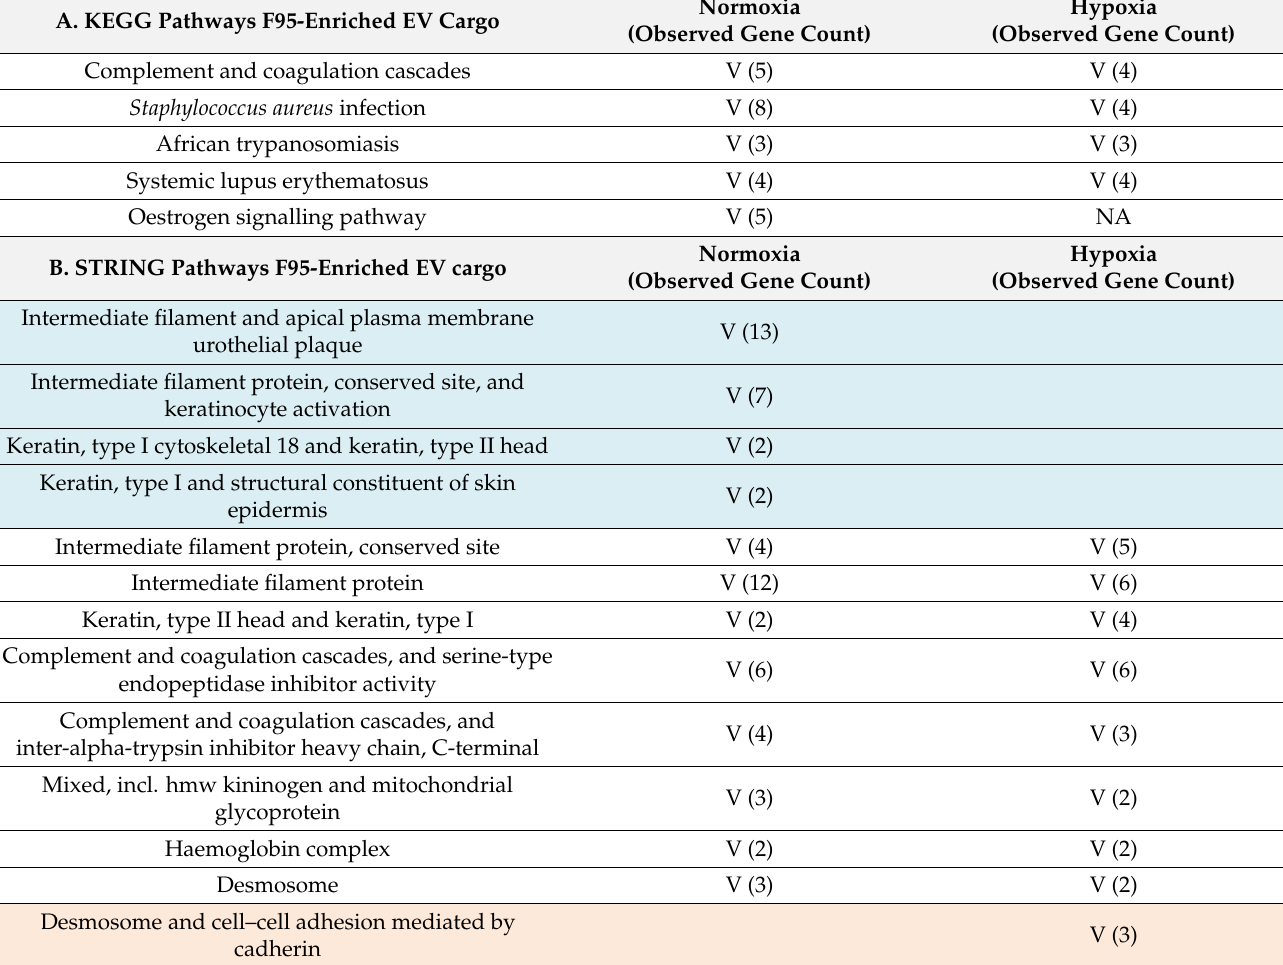
Table 4. EV citrullinome pathway analysis of normoxia- and hypoxia-treated naked mole-rats. (A.) KEGG pathways and (B.) local network cluster STRING pathways for F95-enriched (citrullinome) proteomic content of plasma EVs from of normoxia- and hypoxia-treated naked mole-rats, as assessed by LC-MS/MS analysis. A tick (V) indicates whether the pathway was identified for EV citrullinome protein cargo hits in the respective (normoxia, hypoxia) group; blue highlights pathways identified only in the normoxia, and pink highlights pathways identified only in the hypoxia